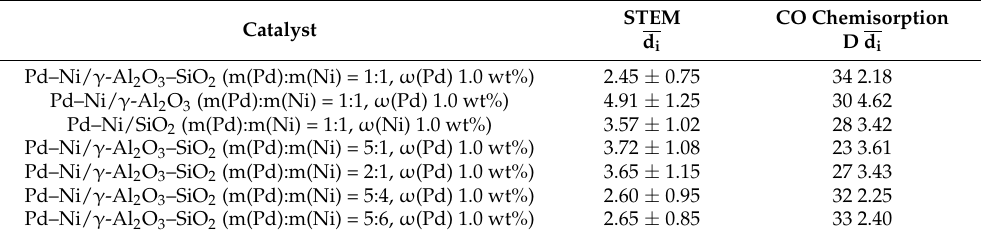
Table 1. Metal dispersion (D, %) and mean particle size (d i , nm) of the metallic phase of the